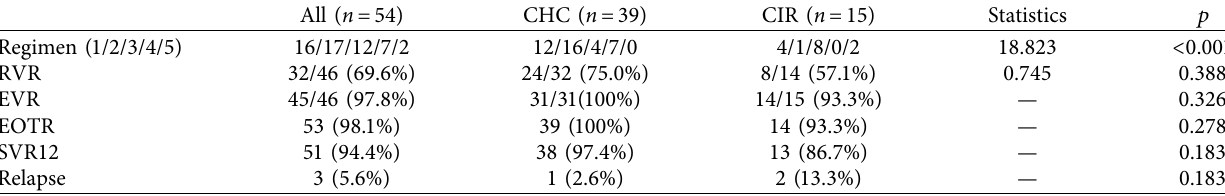
Table 2: The virological response of DAAs